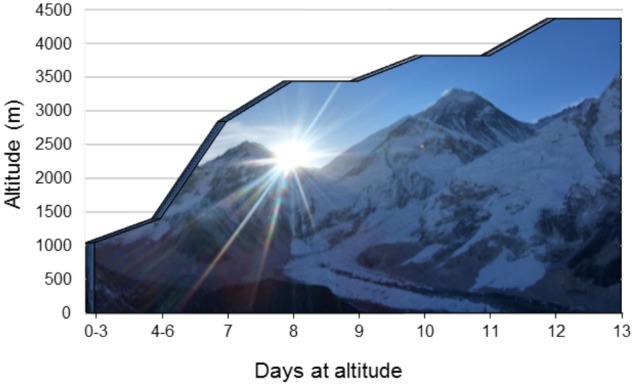
Ascent profile. An illustration of the expedition ascent profile. The days spent at each location are presented on the x-axis with the corresponding altitude of each location presented on the y-axis. Arrows denote measurement location/dates.